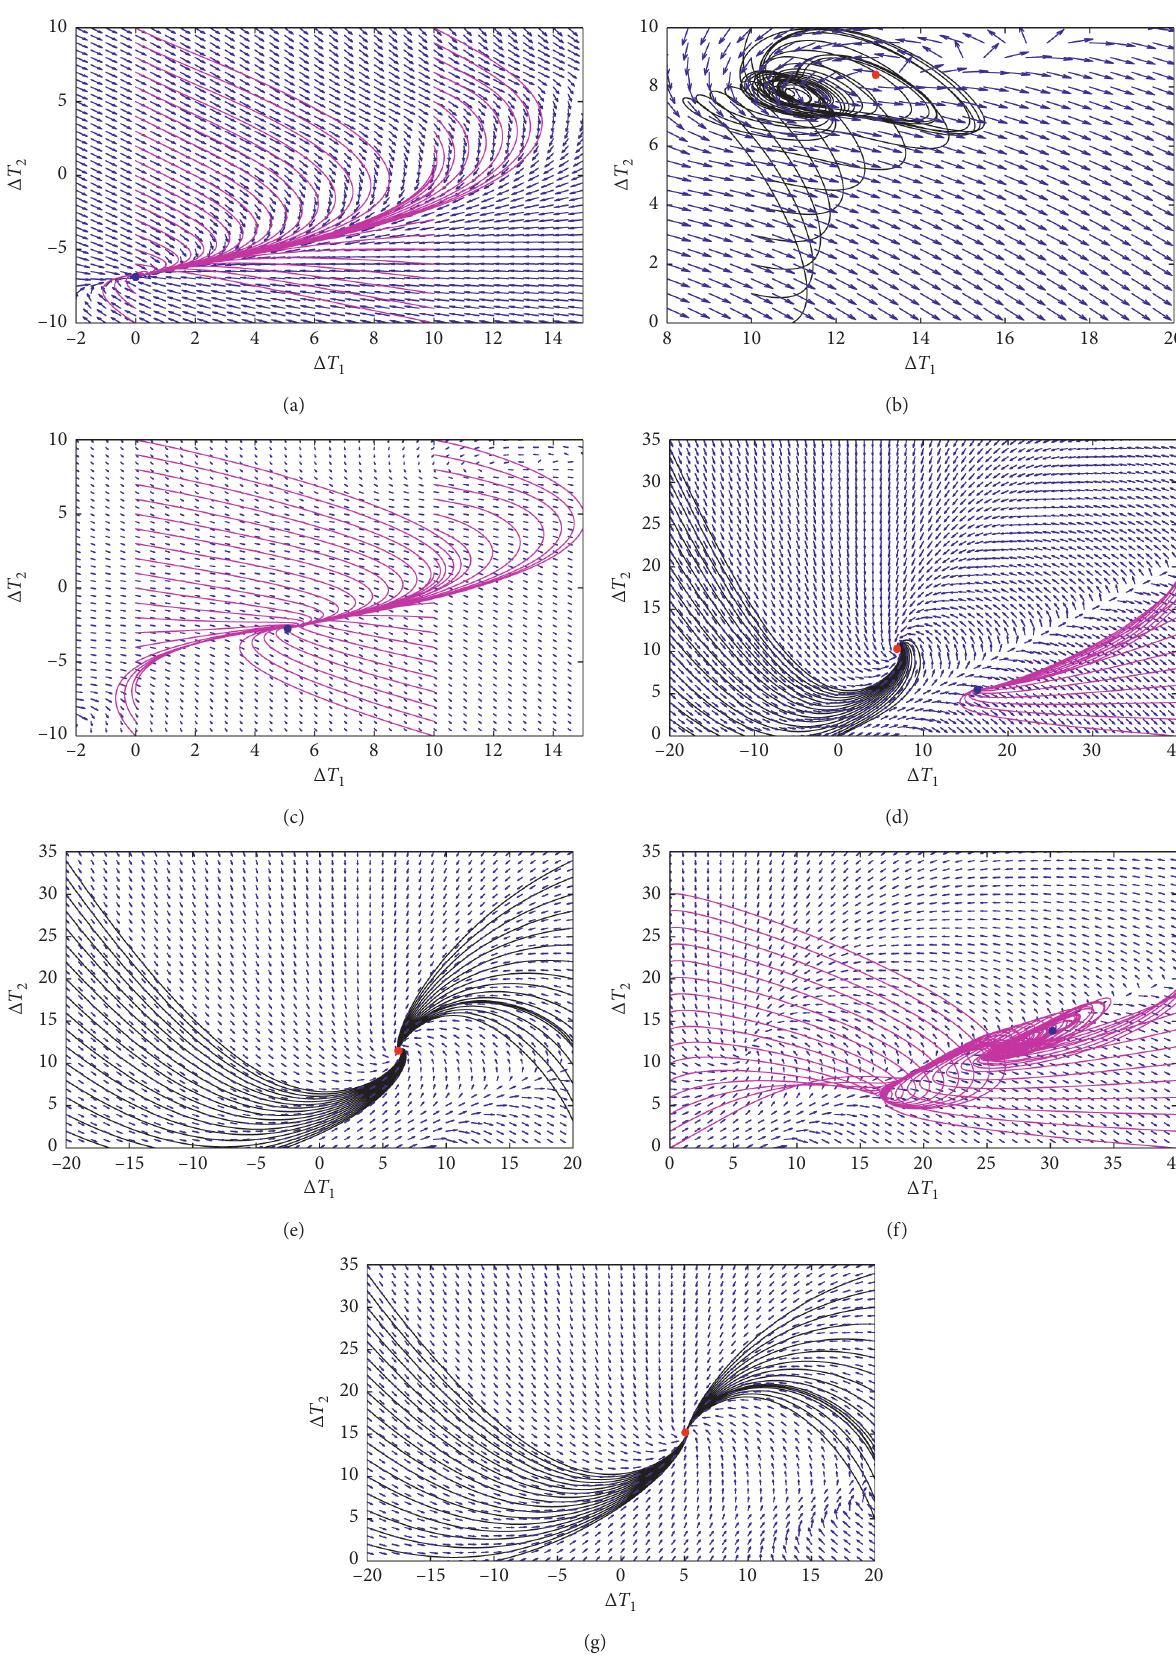
Figure 5: Phase portrait and vector field for scenario 2. (a) α � 2 and k � − 1 of realization 2; (b) α � 2 and k � − 0.35 of realization 1; (c) α � 2 and k � − 0.35 of realization 2; (d) α � 2 and k � 0.5, where the red dot indicates the equilibrium point of realization 1 and the blue dot represents the equilibrium point of realization 2; (e) α � 2 and k � 0.85 of realization 1; (f) α � 2 and k � 0.85 of realization 2; (g) α � 2 and k � 2 of realization